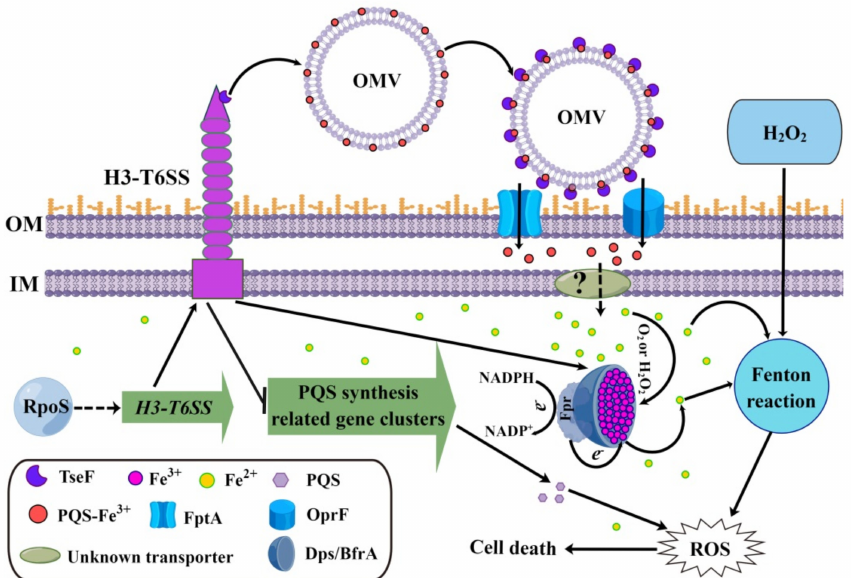
Figure 5. Proposed model of H3-T6SS-mediated resistance to H 2 O 2 stress in P. aeruginosa (created using Figdraw). RpoS indirectly regulates the expression of the H3-T6SS gene cluster. The active H3- T6SS secretes TseF to uptake PQS-Fe 3+ and depends on OMV, FptA, and OprF [30]. The intracellular free Fe 2+ undergoes a Fenton reaction with H 2 O 2 to generate harmful ROS. BfrA and Dps convert intracellular Fe 2+ into Fe 3+ and store it as mineralized iron, while Fpr reduces the mineralized iron in the ferritin to free Fe 2+ and releases it [51]. H3-T6SS mediates the anti-H 2 O 2 stress of P. aeruginosa by upregulating the expression of the iron storage proteins Dps and BfrA and downregulating the expression of the ferredoxin NADP oxidoreductase Fpr, resulting in a reduction of the intracellular free Fe 2+ content. Furthermore, H3-T6SS inhibits the synthesis of PQS to mediate the anti-H 2 O 2 stress of P. aeruginosa . The dashed arrow represents indirect regulation or unknown mechanism, and the solid arrow represents direct regulation or proven